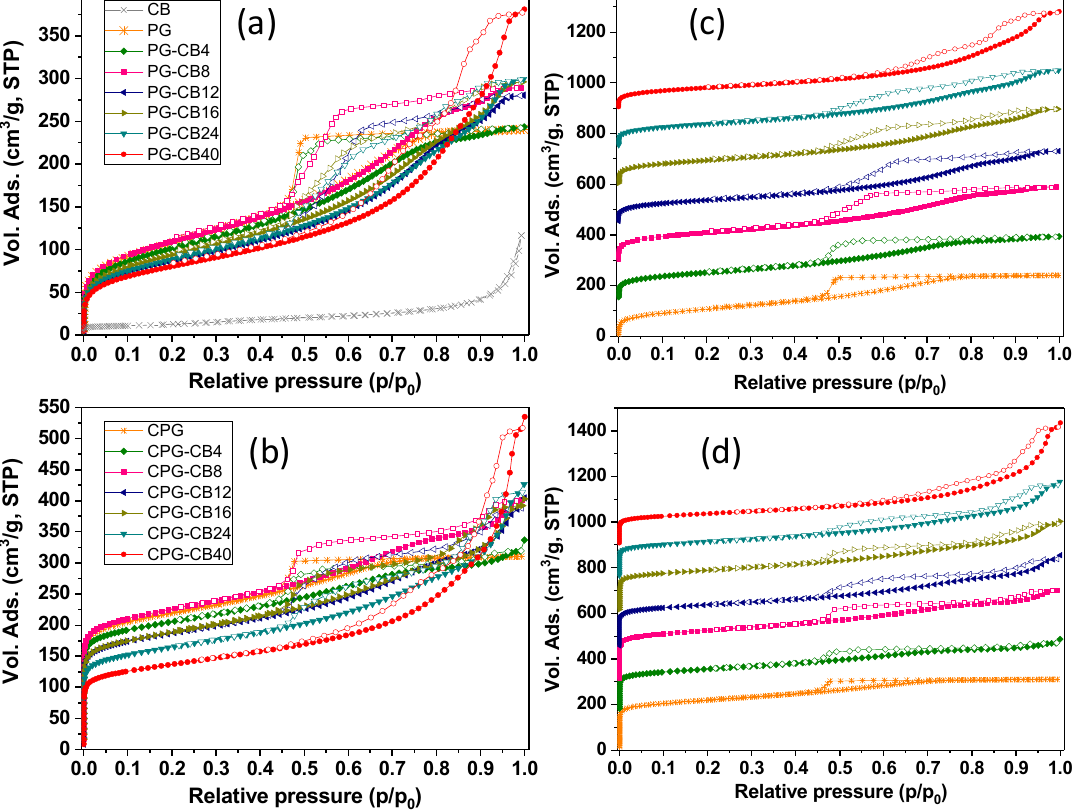
Figure3. ( a , b )N 2 adsorption / desorptionisothermsat − 196 ◦ Coftheorganicandcarbongelssynthesized with di ff erent amounts of CB additive. Data corresponding to the carbon black are also shown as references. Isotherms in plots ( c , d ) have been shifted ca. 150 cm 3 / g for